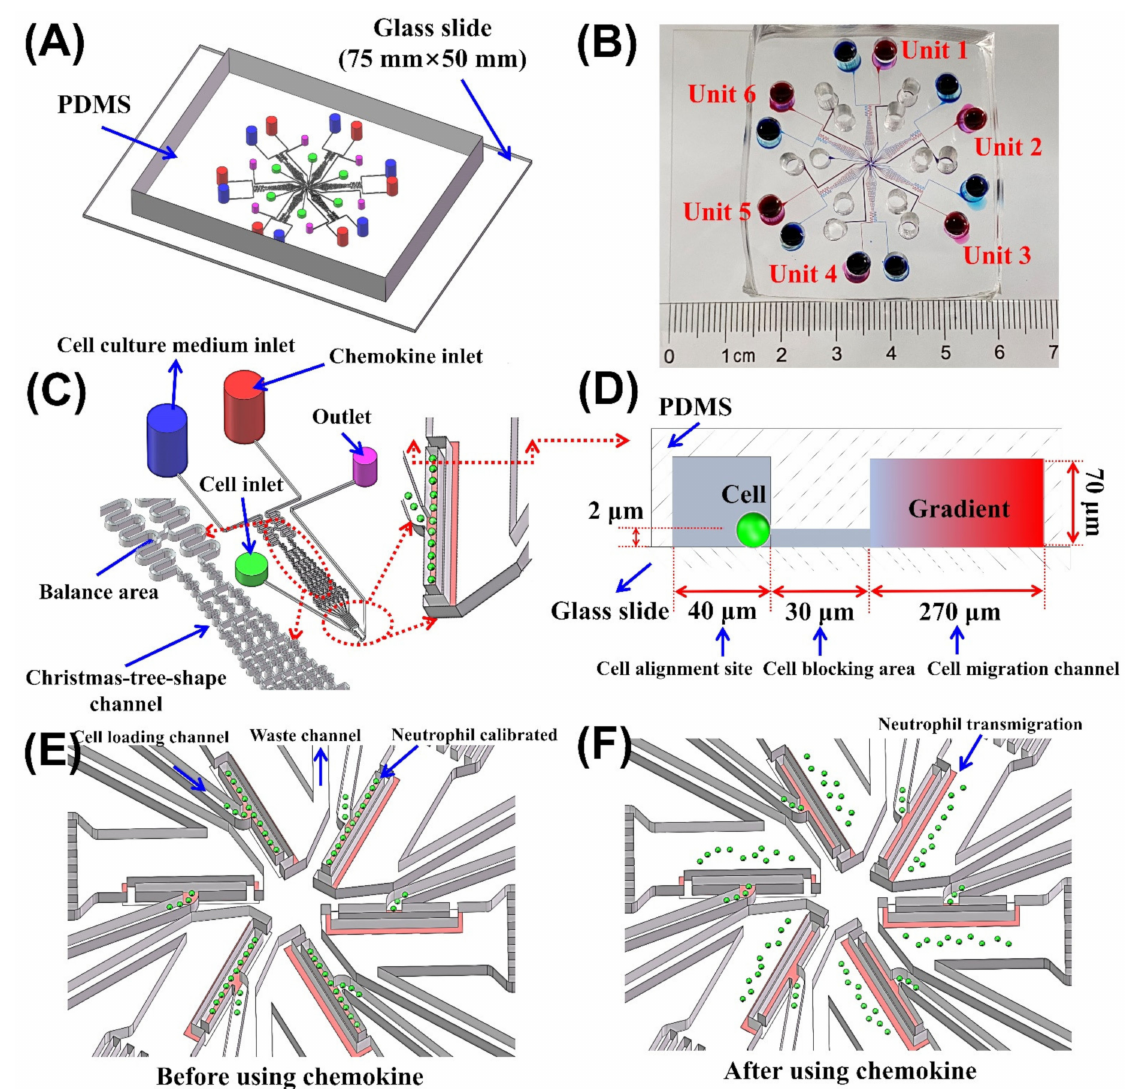
Figure 2. Overall structure diagram of the SC 2 chip. ( A ) Equiaxial side view of the SC 2 chip; ( B ) Front view of the SC 2 chip (photos). ( C ) Enlarged view of an independent test unit. ( D ) Enlarged view of the cell arrangement area. ( E ) Cell distribution in the SC 2 chip before using chemokine. ( F ) Cell distribution in the SC 2 chip after using chemokine for 15